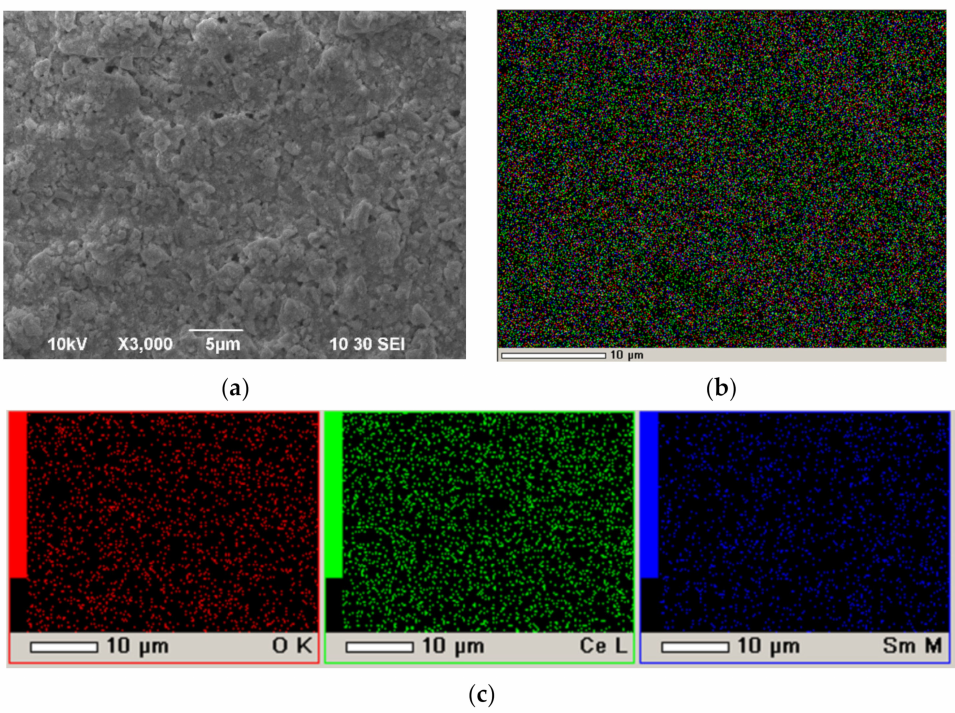
Figure 14. The surface of the layer of unsintered SDC electrolyte on a Ni-foil after annealing at a temperature of 600 ◦ C for 1 h: ( a ) SEM image, magnification × 3000; ( b ) integral map of the elements’ distribution; ( c ) individual element